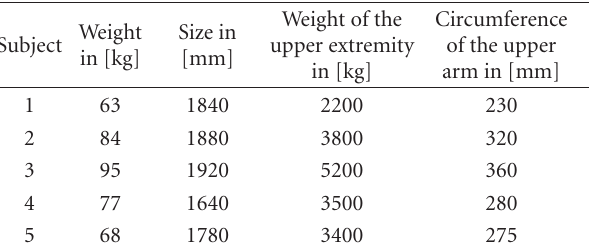
Figure 10: Step response of the actuator for internal rotation with 300kPa pressure. Table 4: Body dimensions of the subjects.